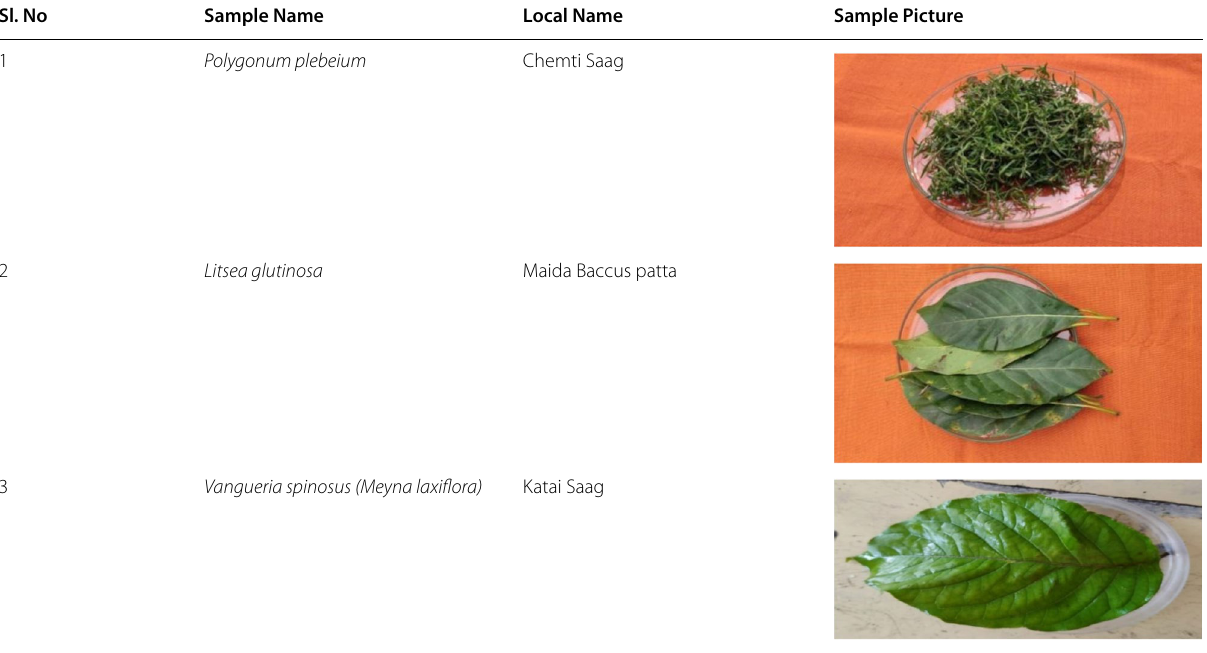
Table 1 List of selected indigenous plant with their local name Sl.